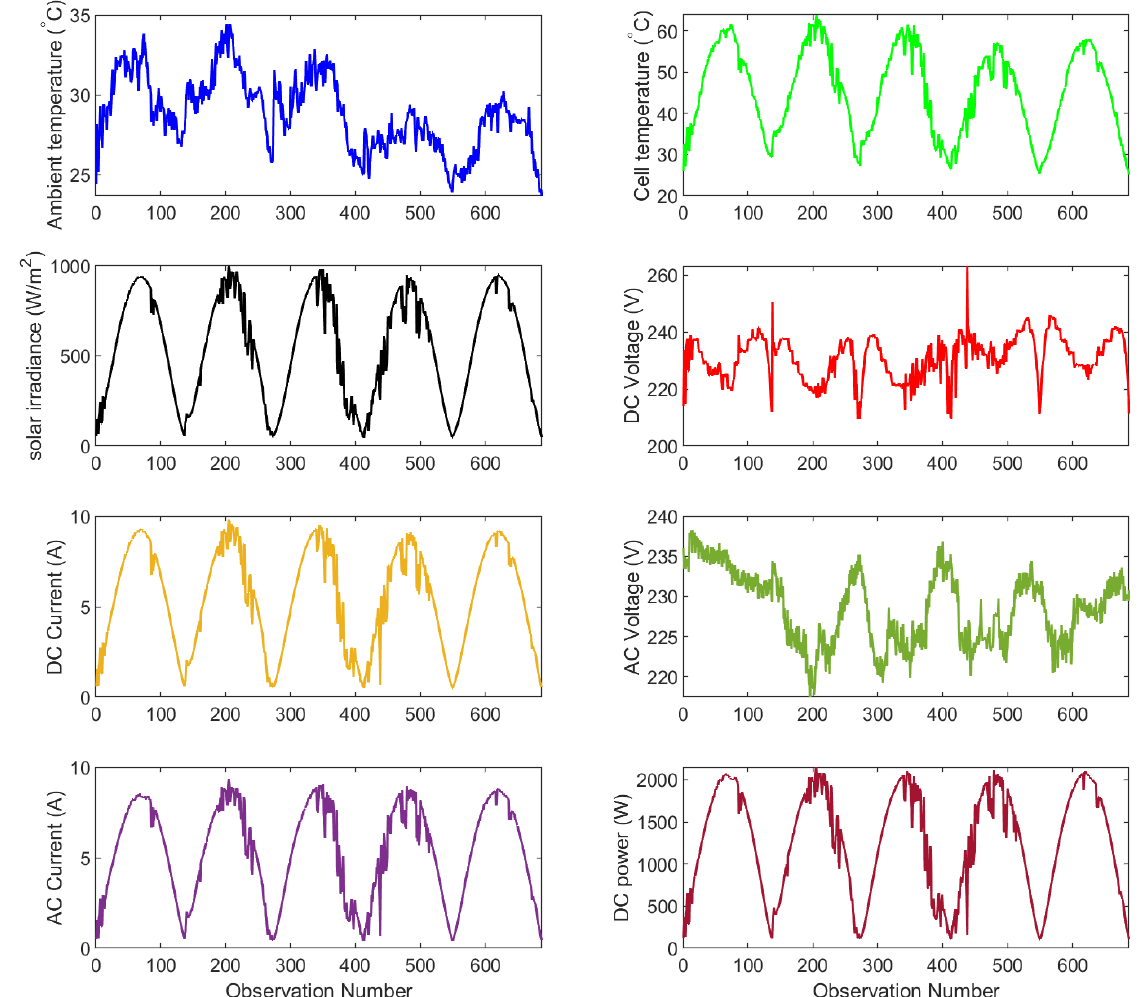
Figure 6. Five days of the studied PV data.